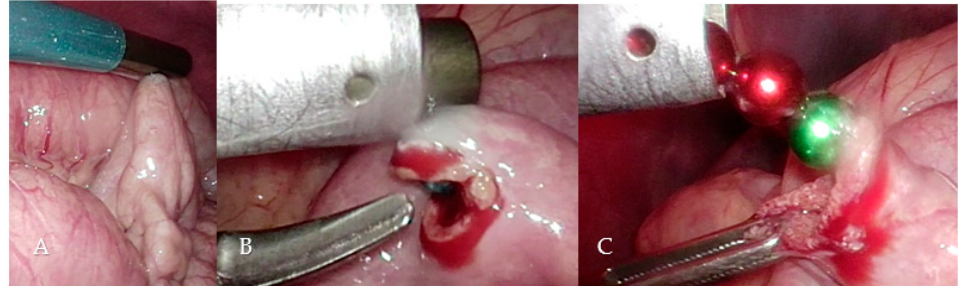
Figure 6. Magnetically adherent small bowel loop ( A ), enterotomy with visible blue magnetic ball ( B ), removal of the magnetic balls ( C ) (see also Video S2).